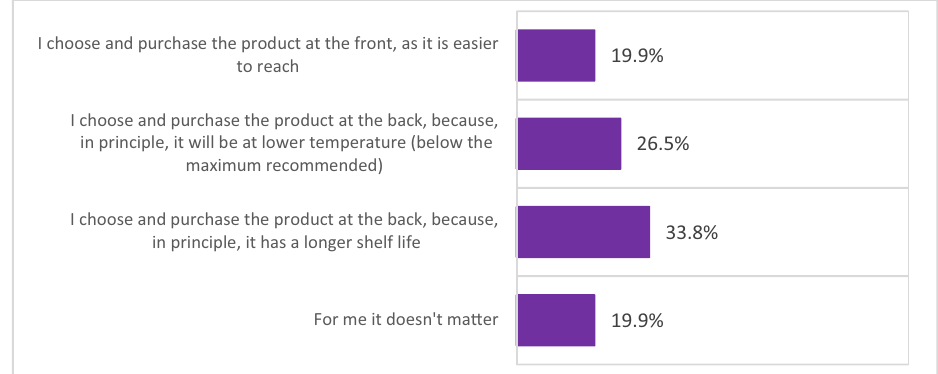
Figure 7: Results for the question: “ Select the statement that best represents your behavior when choosing and/or purchasing food products from vertical RDC ” .